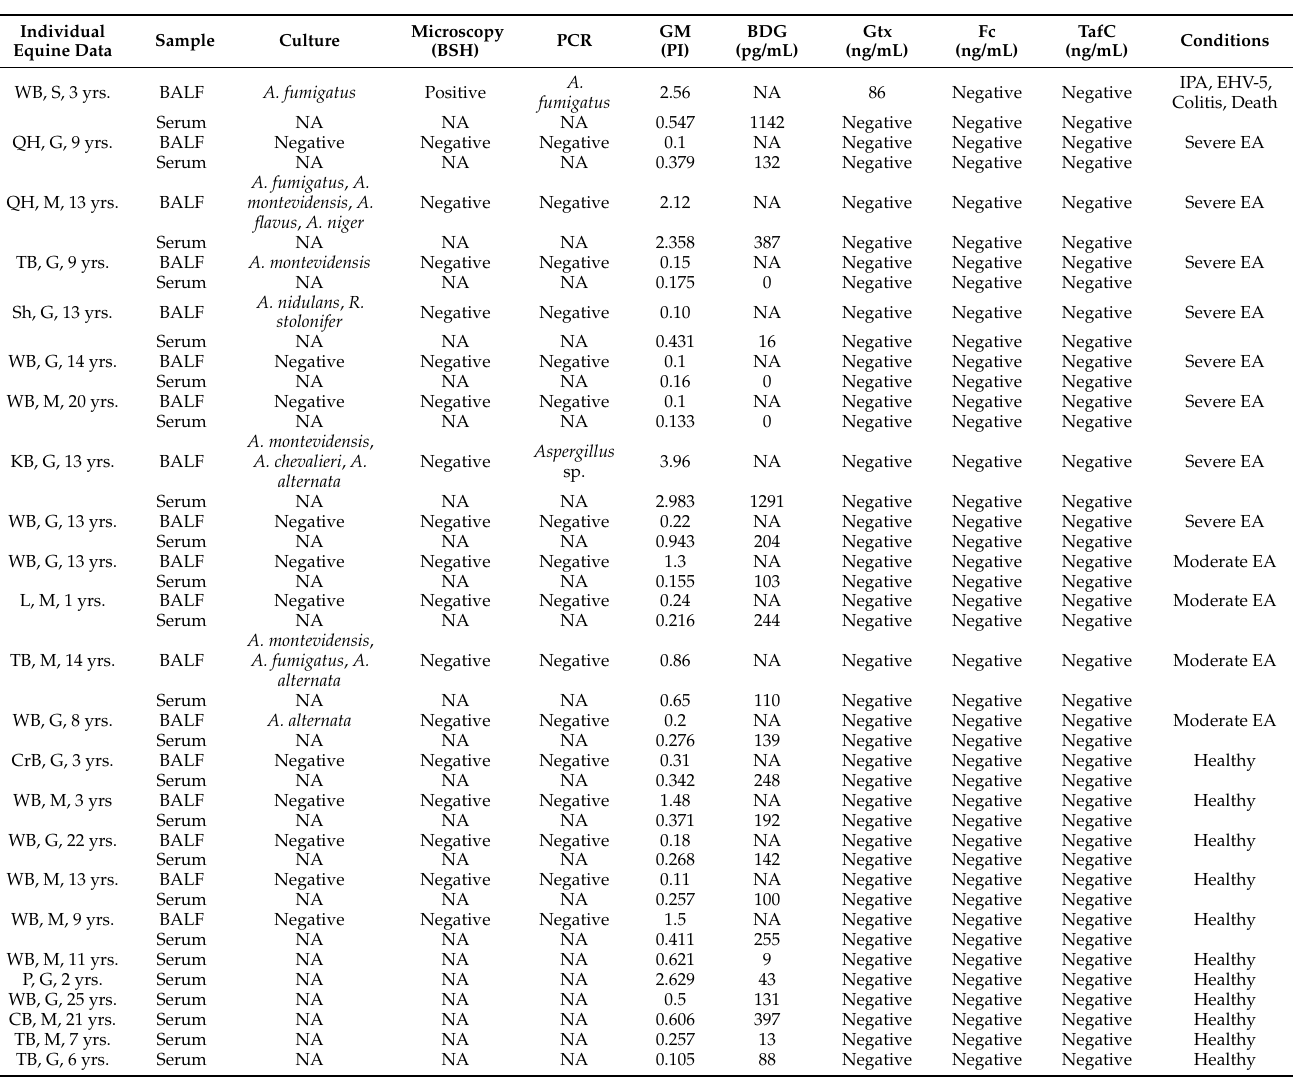
Table 1. Horses enrolled in the study, IPA vs. control groups (n =